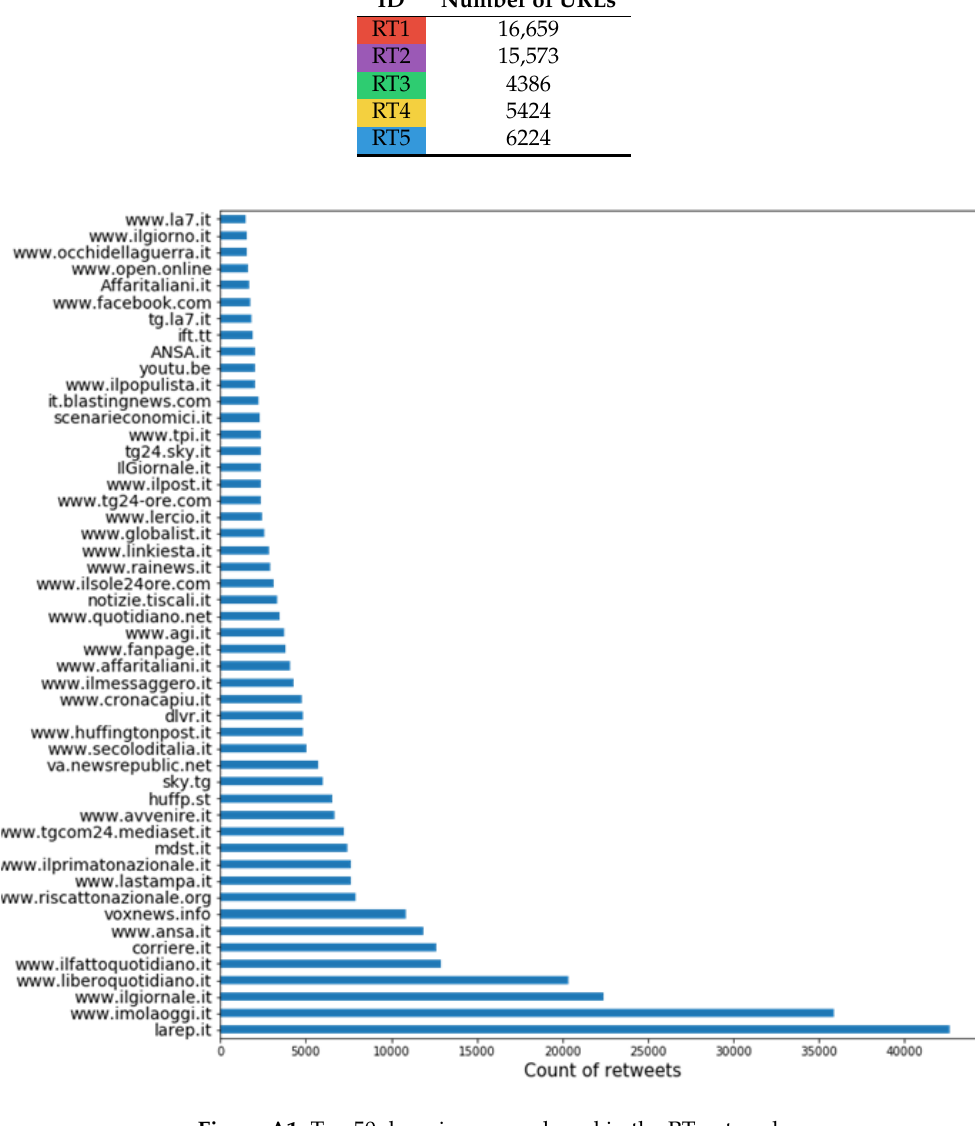
Figure A1. Top 50 domain names shared in the RT